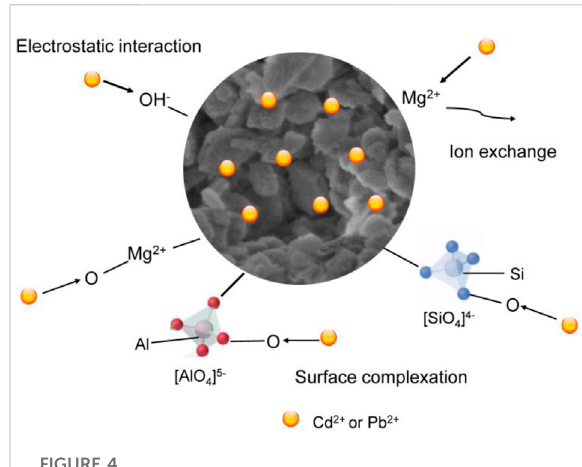
FIGURE 4 The adsorption mechanisms of Cd(II) and Pb(II) onto